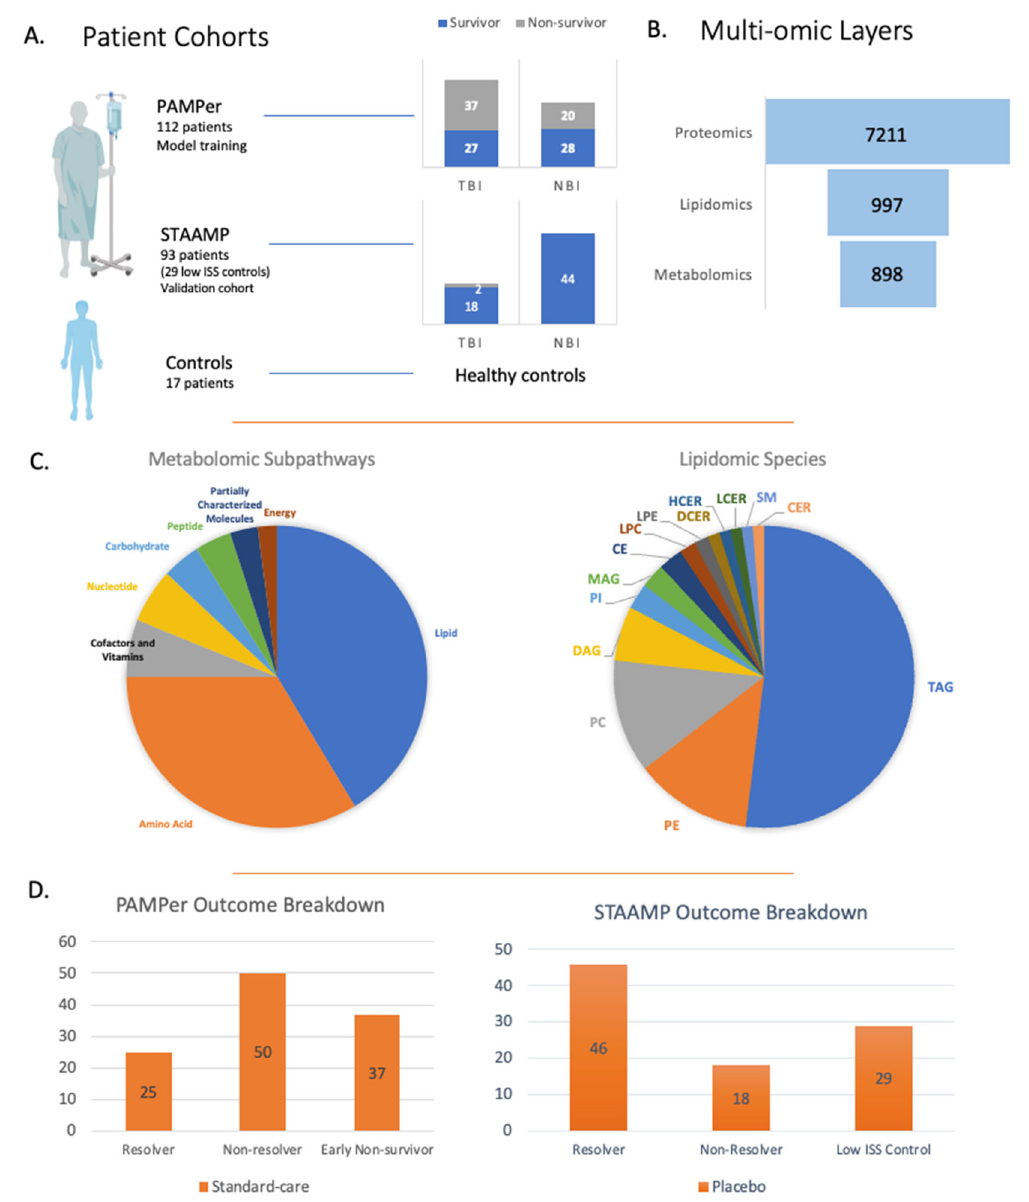
Figure 1. Overview of patient cohorts and multi ‐ omic layers. ( A ) Breakdown of patients from the clinical trials used to develop the predictive model and validation model looking at 30 ‐ day survival and traumatic brain injury. ( B ) Breakdown of multi ‐ omic layers and number of variables used for the predictive modeling. ( C ) Metabolomic and lipidomic subpathways and species. ( D ) Overview of patients from PAMPer and STAAMP clinical trials looking at outcome based on ICU LOS/time of death.